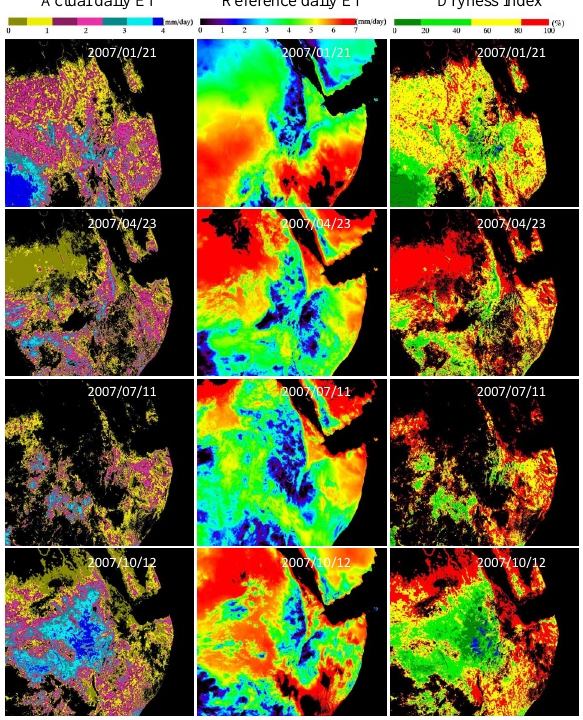
Fig. 3 . Sample maps of (left panel) actual daily ET, (middle panel) daily reference ET, and (right panel) daily dryness index in different seasons in the study region.